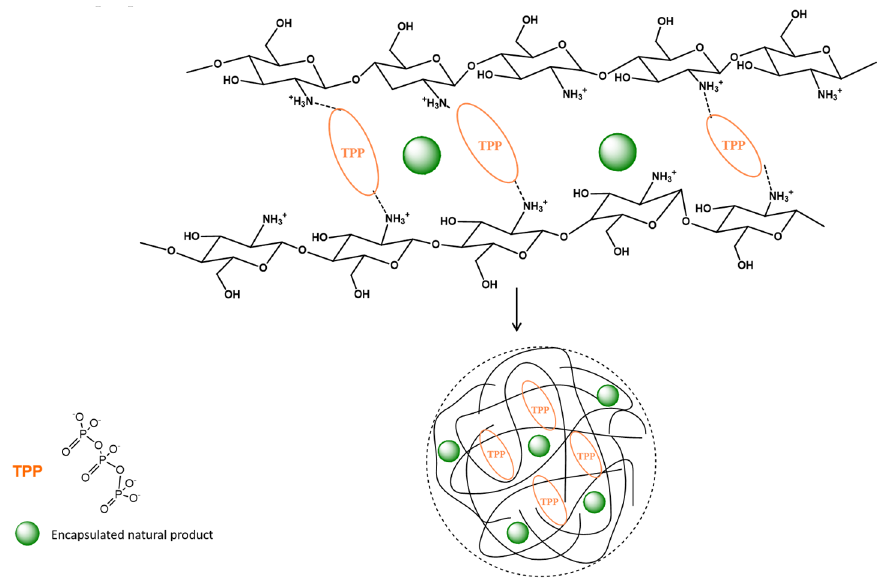
Figure 1. Schematic representation of the formation of chitosan nanoparticles encapsulating natural products via the ionic gelation technique.